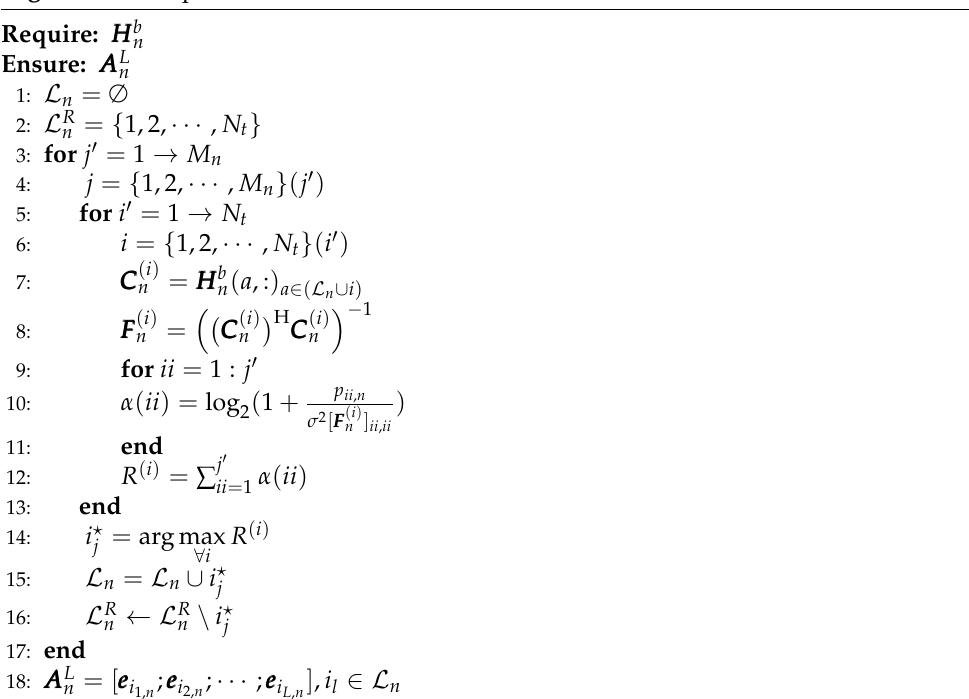
Algorithm 2 Proposed incremental beam selection